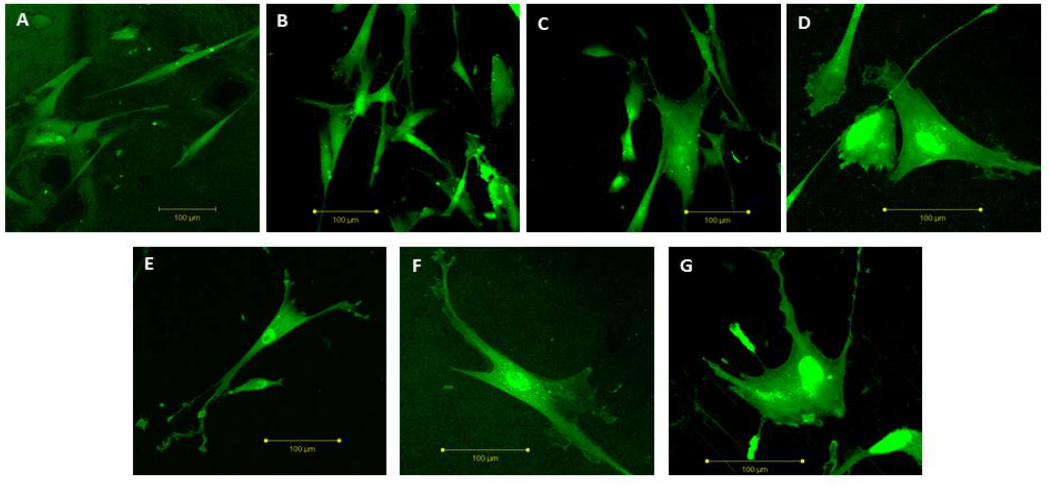
Figure 9. Confocal micrographs of hMSC grown on ( A ) HDPE, ( B ) HDPE.Cl.0125, ( C ) HDPE.Cl.0250, ( D ) HDPE.Cl.0500, ( E ) HDPE.MeS.0125, ( F ) HDPE.MeS.0250, and ( G ) HDPE.MeS.0500 (scale bar = 100 μm).